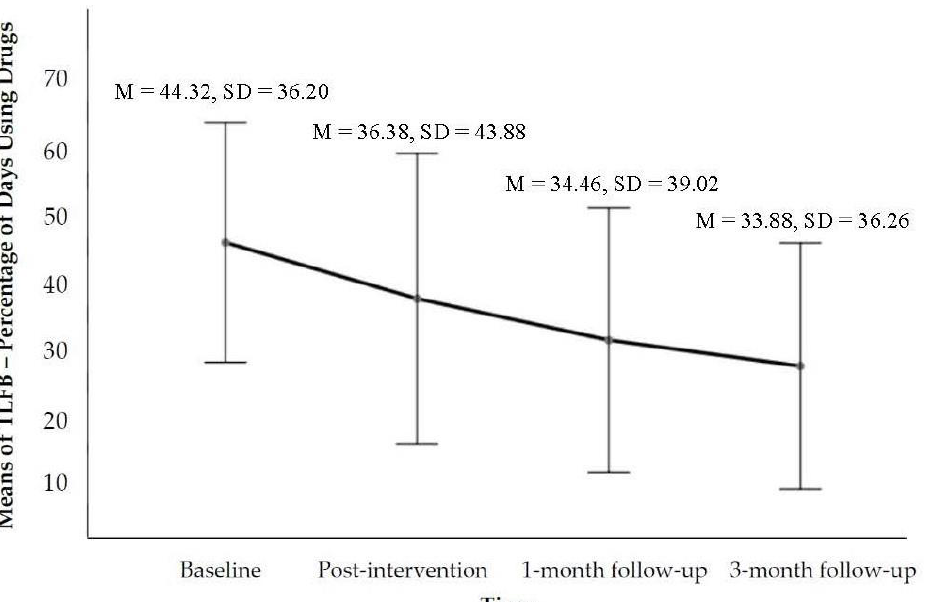
Figure 1. Estimated marginal means plot showing the TLFB changes as percentages of days across the four time points.